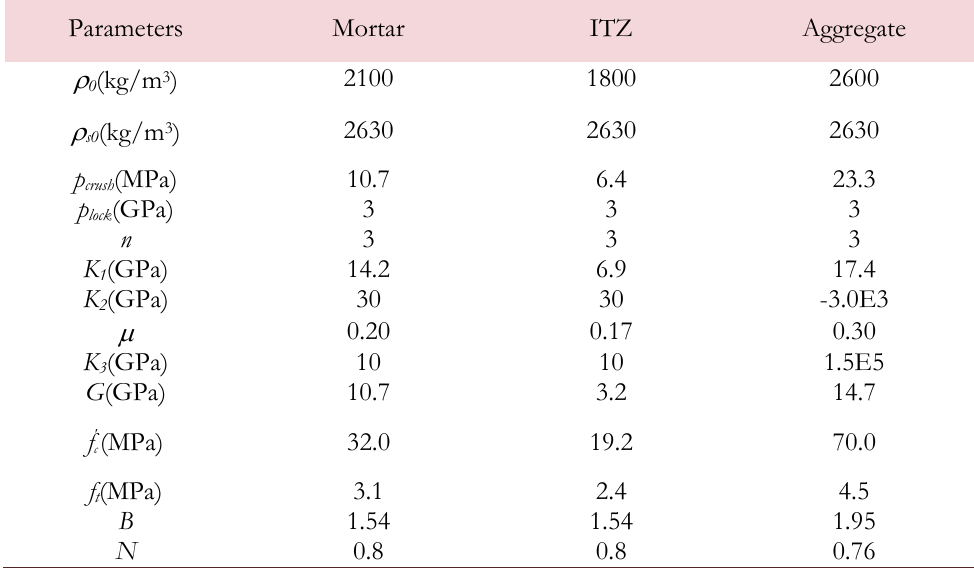
Table 1: Parameter values of the 3D meso-mechanical